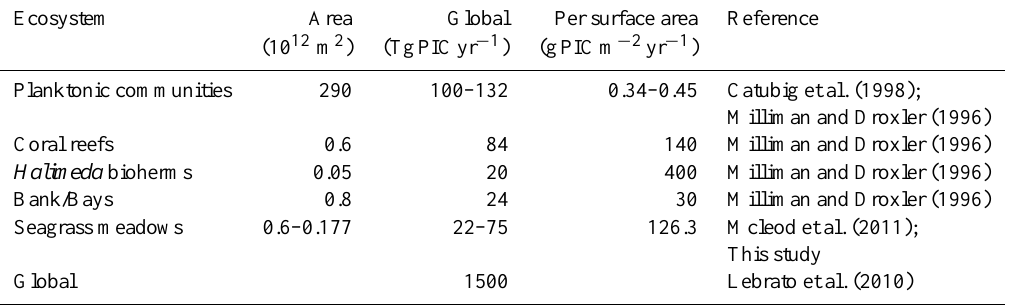
Table 3. Estimated area, and PIC accumulation rates globally (TgPICyr − 1 ) and per surface area (gPICm − 2 yr − 1 ) for different carbonate producing ecosystems including the results found for seagrasses in this study and a global estimation considering neritic, slopes, and pelagic areas along with organism-level